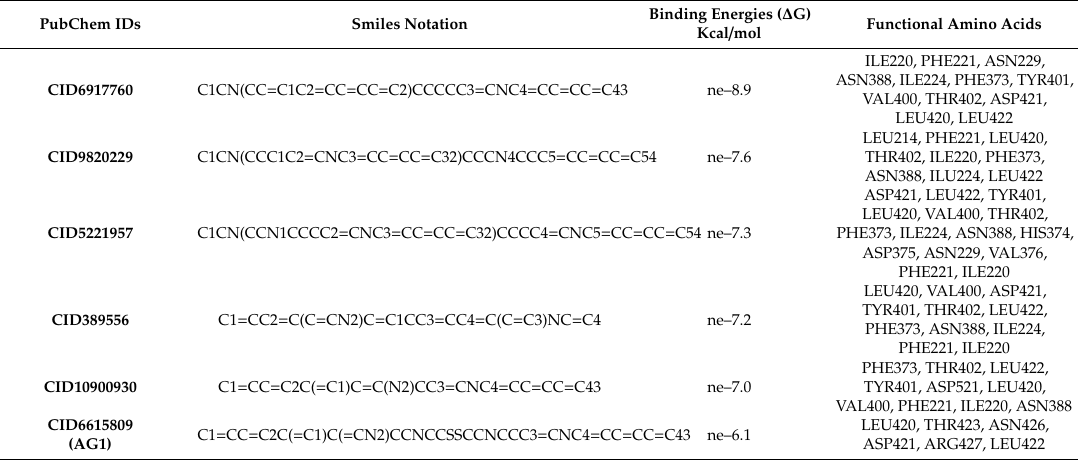
Figure 6. Molecular docking analysis illustrated all the drug-like (18) molecules docked into the G6PD-dimer interface active site (top). The binding energy of the top five compounds was aligned and superimposed (bottom). Table 1. Molecular docking scores (kcal / mol) and functional residues of the active molecules in the binding site of the protein